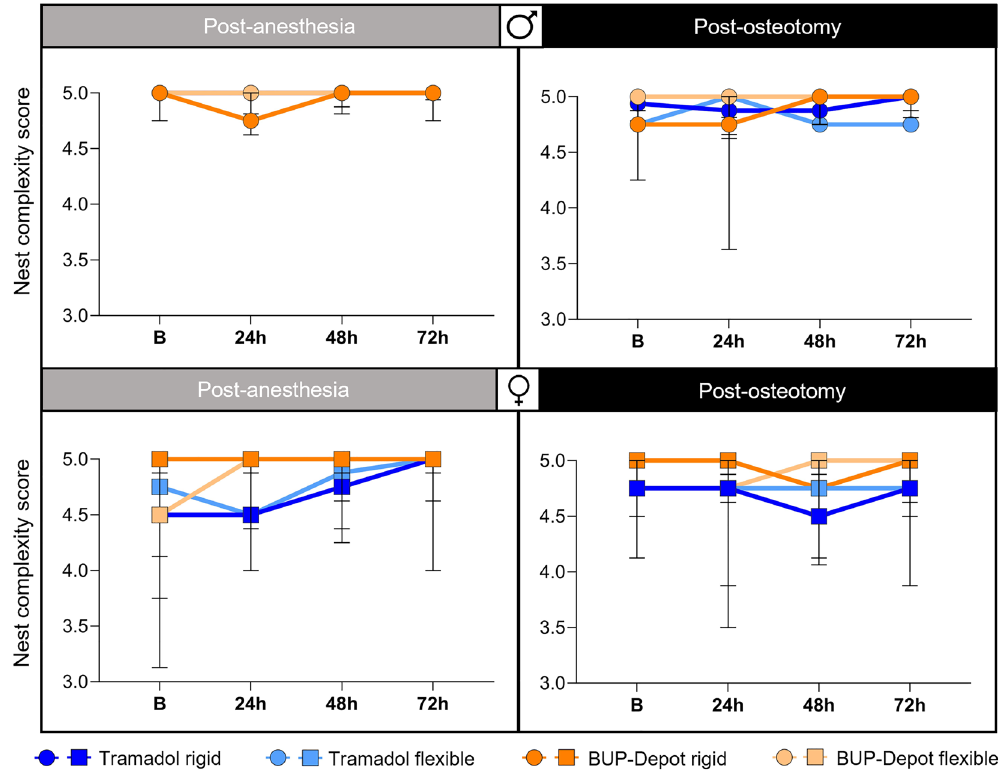
Figure 3. Nest building behavior remains largely unaffected post-anesthesia and post-osteotomy. Nest building was monitored per cage at 24 h, 48 h and 72 h post-anesthesia and post-osteotomy. All graphs show median with interquartile range for n = 4–5 based on cages (pair housing). B baseline